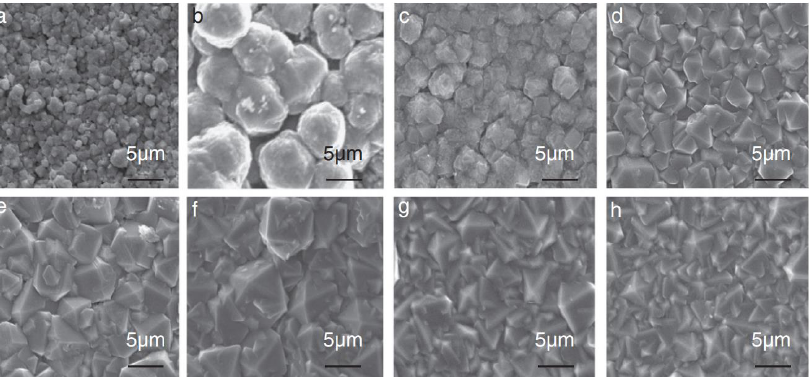
Figure 2. SEM images of diamond coating deposited on WC-Co substrates pretreated by: ( a ) abrading; ( b ) Cr interlayer deposition; ( c ) Nb interlayer deposition; ( d ) Ta interlayer deposition; ( e ) chemical etching; ( f ) chemical etching and Cr interlayer deposition; ( g ) chemical etching and Nb interlayer deposition; and ( h ) chemical etching and Ta interlayer deposition [28].